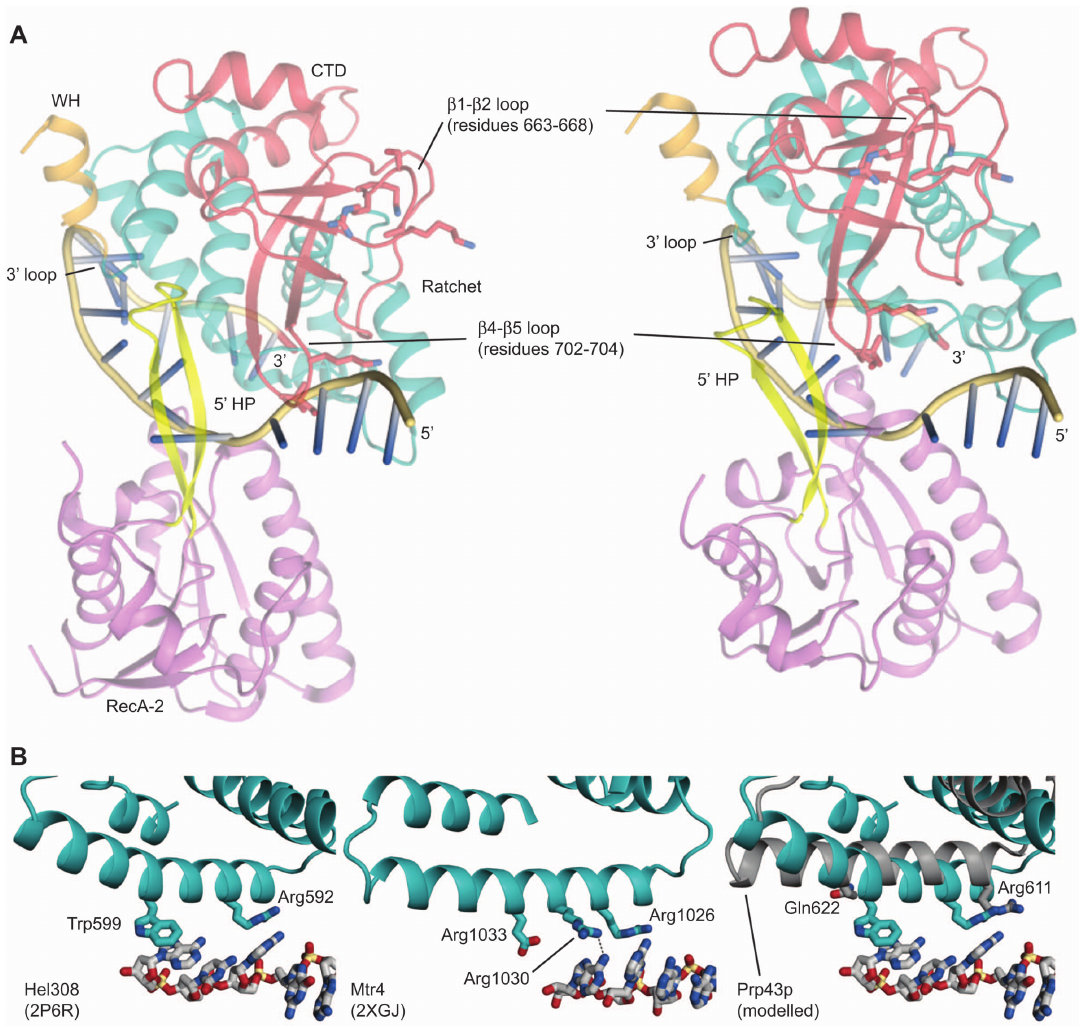
Figure 4 The putative nucleic acid-binding pocket of Prp43p. (A) Comparison of the binding pocket between the ADP state (left panel) and the modeled nucleic acid-bound state (right panel). Residues of the b 1– b 2 and b 4– b 5 loops in the CTD proposed to bind RNA are shown as sticks. The longer DNA strand from the Hel308 structure (Figure 3C) was docked by superimposition of the Prp43p RecA domains with the equivalent Hel308 domains. (B) The long helix in the ratchet domains of Hel308 (left panel) and Mtr4 (middle panel) interact with bound DNA and RNA. Conserved residues pointing towards the binding pocket are shown as sticks. The corresponding helix in Prp43p in the modeled nucleic acid bound state (gray) is shown in comparison with the Hel308 helix interacting with DNA (right panel). Conserved residues Arg611 and Gln622 of Prp43p are shown as